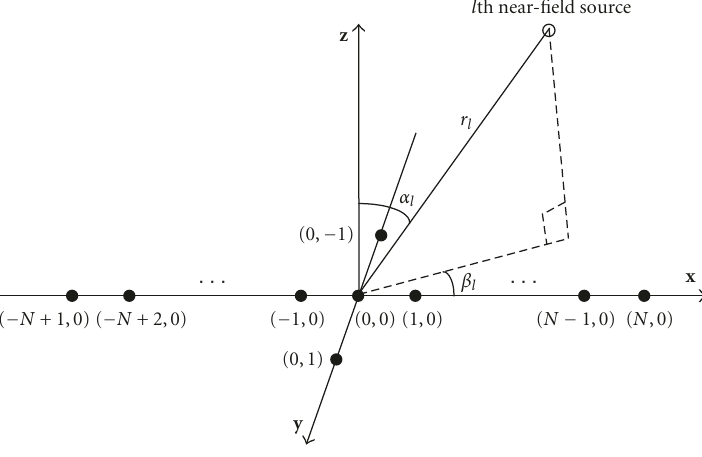
Figure 1: proposed cross-array for 4D near-field source localization